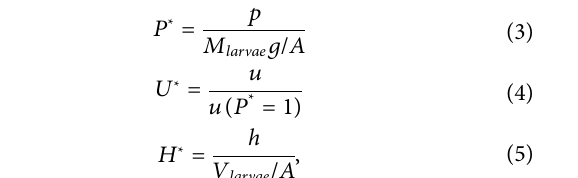
TABLE 1 | Dimensionless parameters in the experiments and simulations. Dimensionless